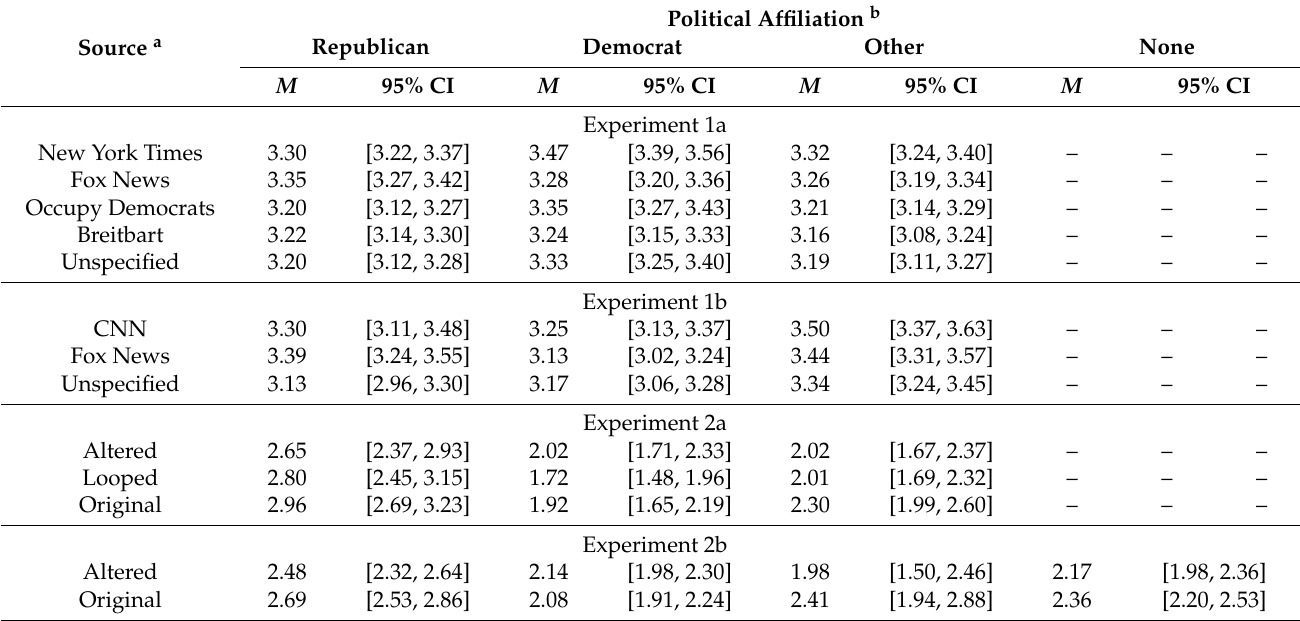
Table 1. Descriptive Statistics for Ratings of News Classified by Source of Material and Subjects’ Political